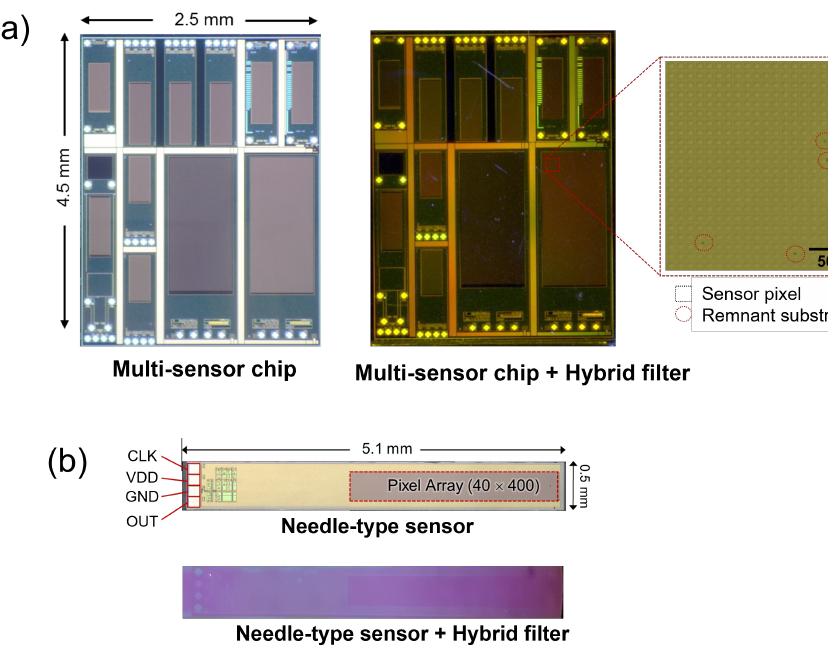
Figure 3. Photographs of the image sensor before and after filter deposition. ( a ) After etching, the multisensor area in the chip is flawlessly covered by a hybrid filter. The enlarged image shows the Si remaining on the filter post-etching (black dots). ( b ) Uniform hybrid filter covering the entire area of the needle-type sensor after